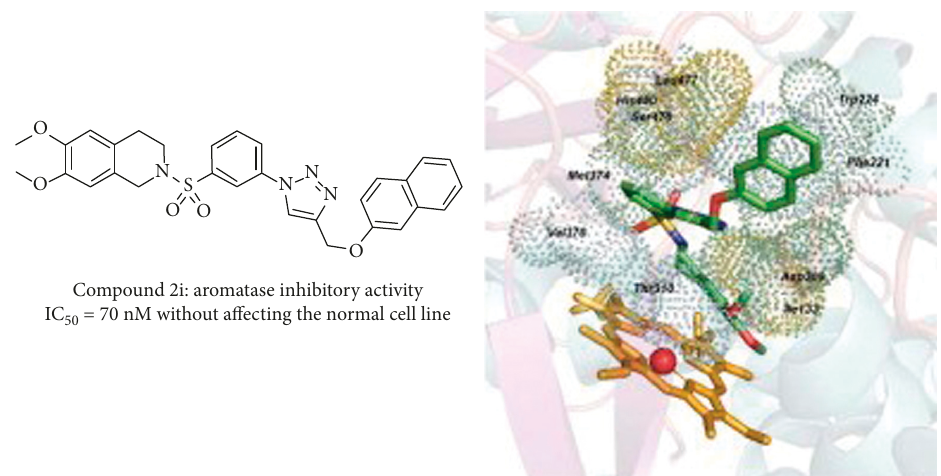
Figure 3: Aromatase inhibition activity of compound 2i, compound 2i binded to the active site of the aromatase enzyme. Copyright 2019. Reproduced with permission from Elsevier.